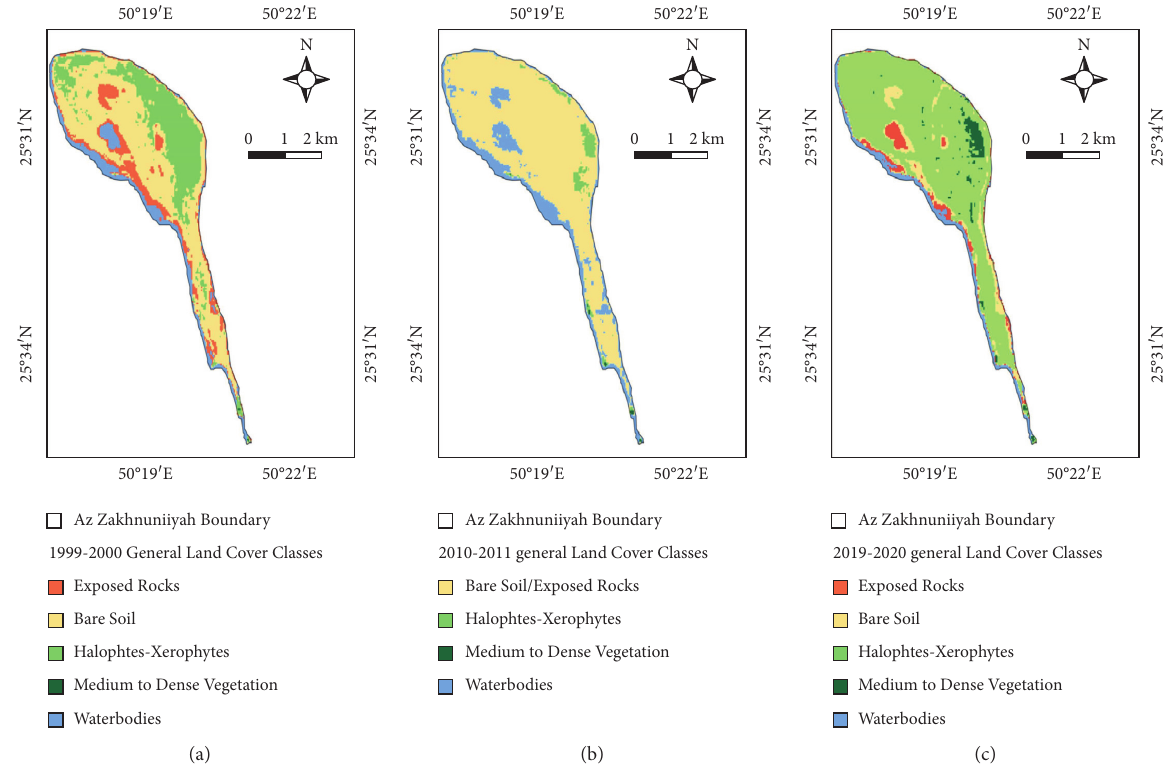
Figure 2: General land cover maps (a) based on 1999-2000 NDVI, (b) based on 2010-2011 NDVI, and (c) based on 2019-2020